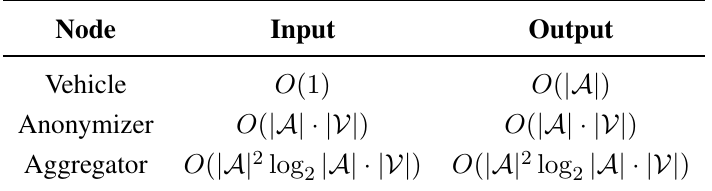
Table 2. Asymptotic complexity in terms of incoming/outgoing messages per node for the scheduling of a single service request.